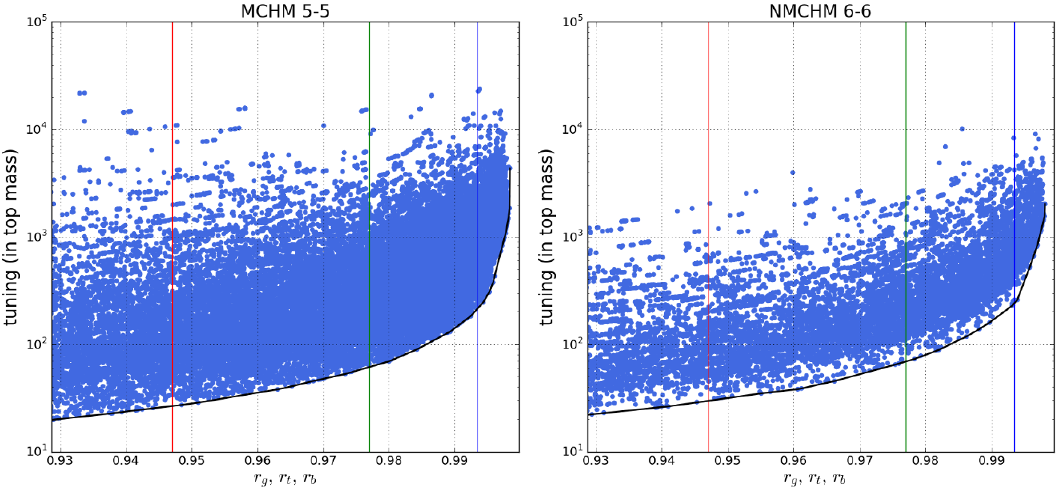
Figure 5. Comparison of the (cid:12)rst-order tuning contribution from the top mass, in the Higgs-gluon, -top and -bottom coupling deviation. The red line shows the expected precision of a 250 GeV ILC, green a 500 GeV ILC, and blue a high-luminosity 1 TeV ILC.